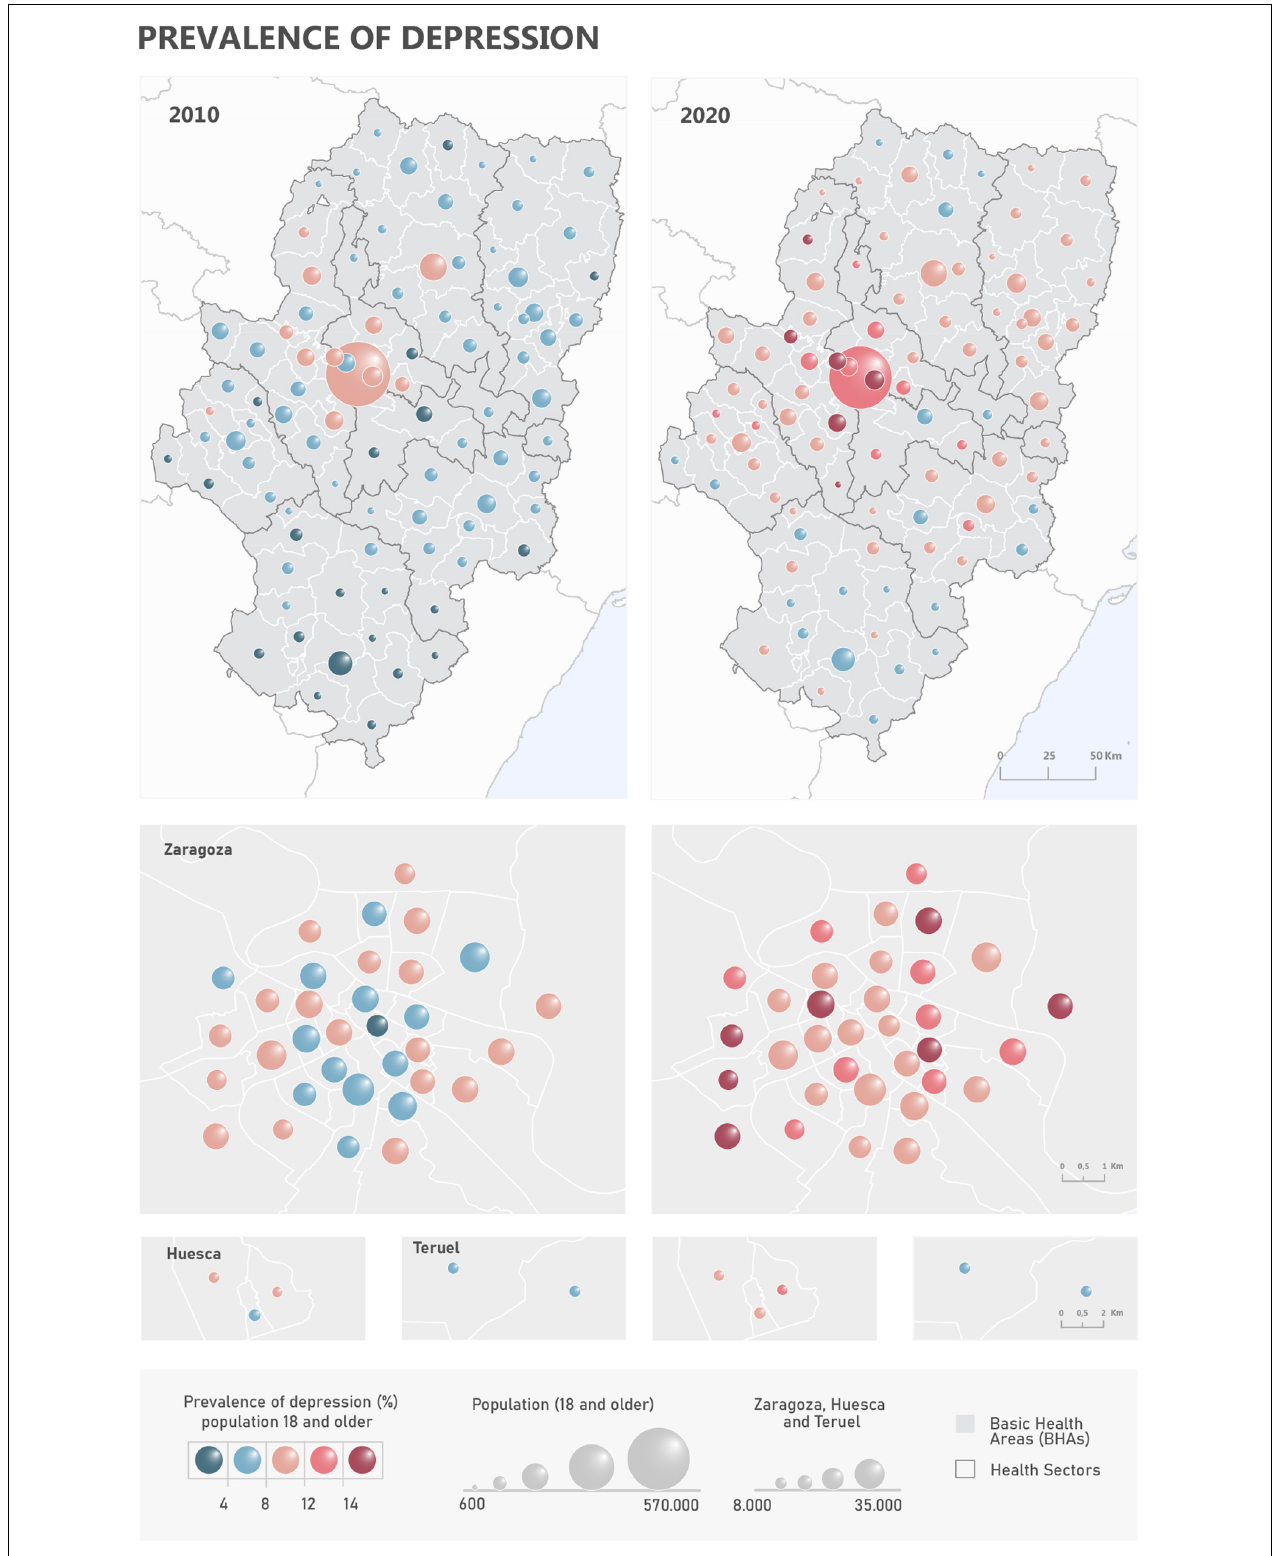
FIGURE 2 | Spatial distribution of the prevalence of depression in 2010 and